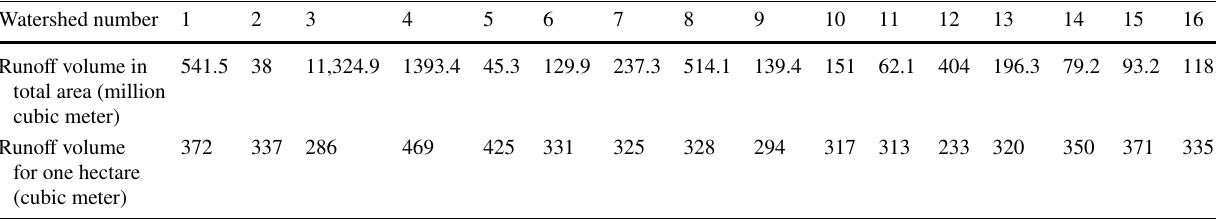
Table 3 Runoff volume of the maximum 24-hour precipitation with a return period of 100 years (design storm) Watershed number 1